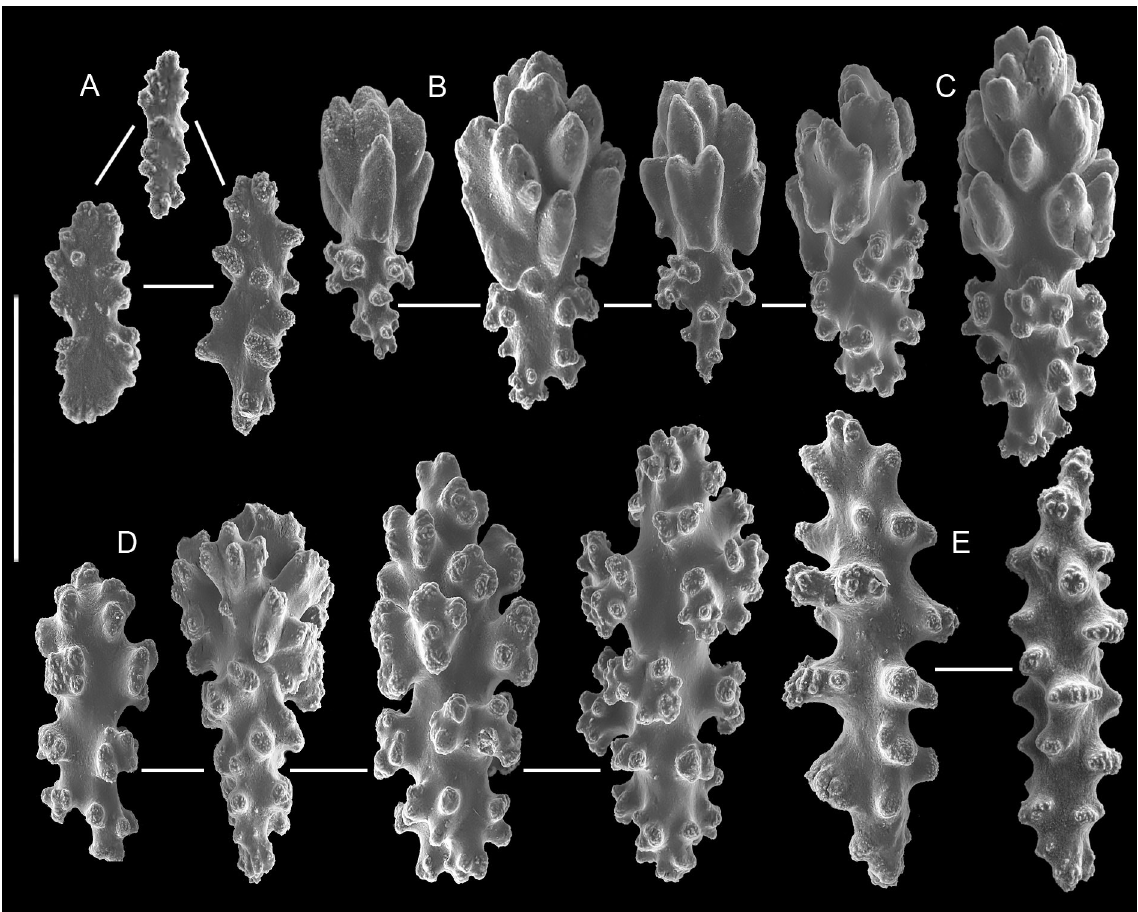
Fig. 2. Calcigorgia matua sp. nov., holotype (MIMB 20722), sclerites from the tentacles of polyp. A . Flattened bodies. B . Clubs with a head consisting of leafy processes. C . Longer clubs with staggered leafy processes on a head. D . Warty clubs. E . Spindles. Scale bar: 0.1